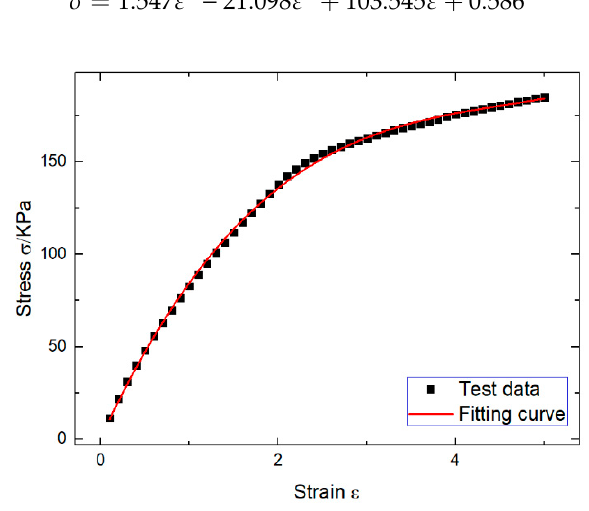
Figure 4. Stress-strain curve of the DMA tensile strain scanning.